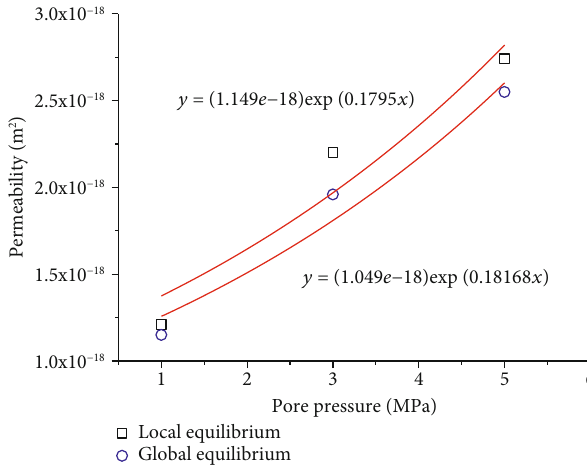
Figure 14: Pore pressure vs. local equilibrium permeability and global equilibrium permeability under constant con fi ning stress.